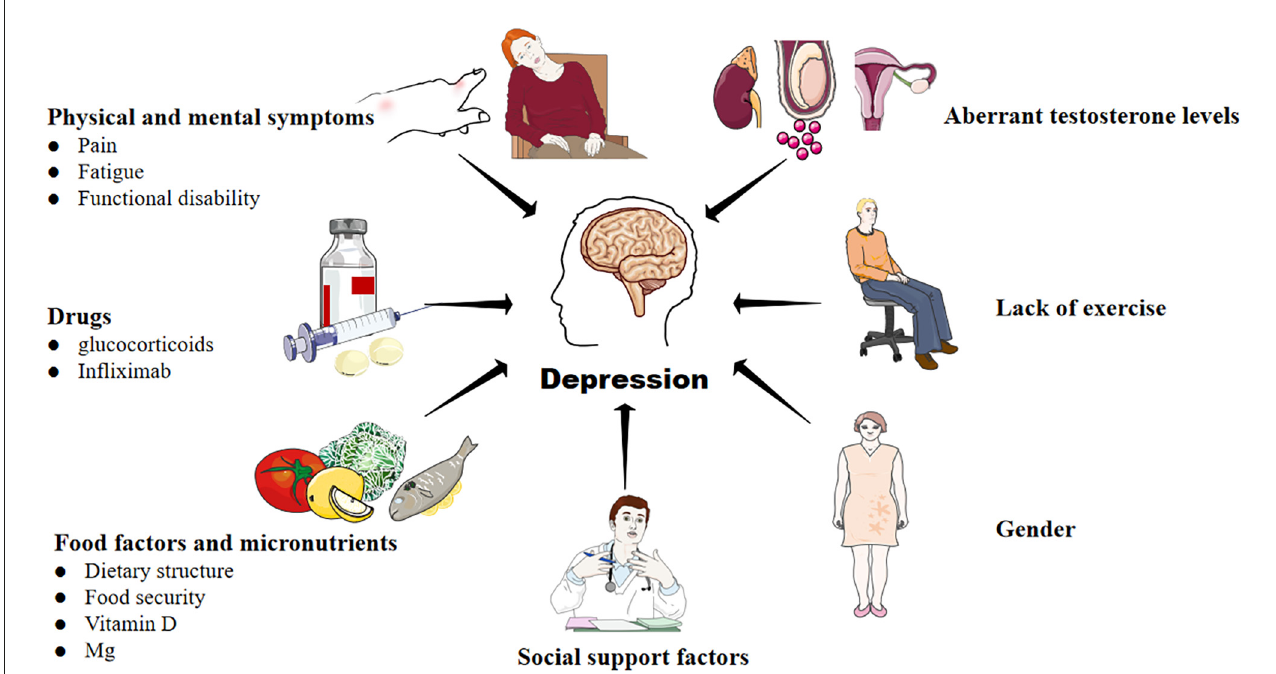
FIGURE1 Factorsthatcontribute tothedevelopmentofdepressionin RA.Avarietyofcomplexand comprehensivefactors,includingphysicaland mentalsymptoms, drugs, food and micronutrients, lack of exercise, aberrant testosterone levels, and social support may contribute to depression in RA.